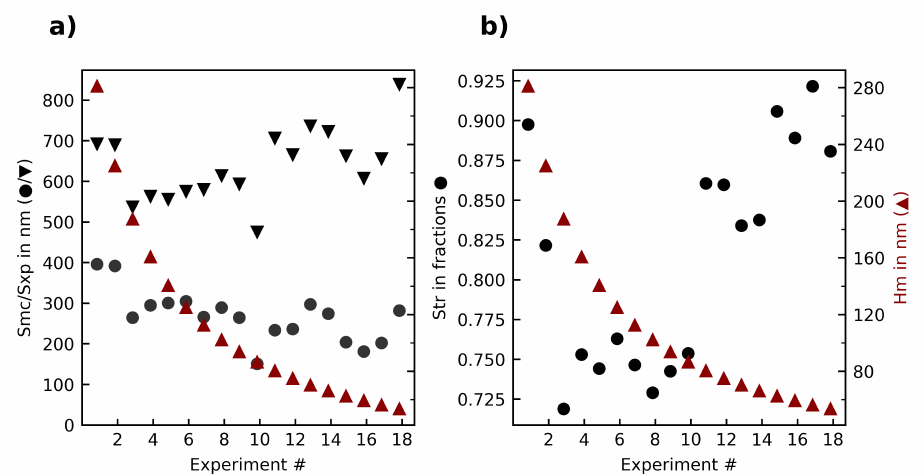
Figure 6. Overview of the ( a ) material ratio parameters Smc, Sxp; ( b ) texture aspect ratio (Str) in relation to the median chip thickness Hm in the first experiment